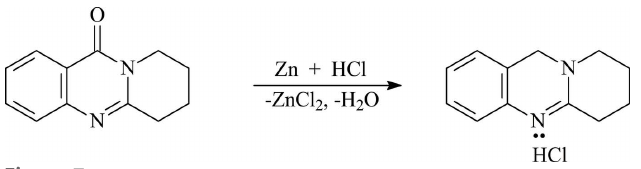
Figure 7 Synthesis scheme for 2,3-tetramethylene-3,4-dihydroquinazoline hydro- chloride.